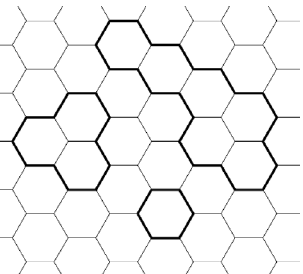
Figure 1. A loop con(cid:12)guration on the honeycomb lattice. In this example we have N links = 40 and N loops =